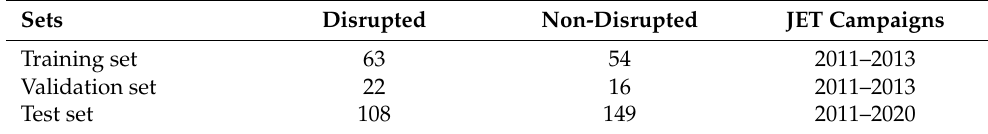
Table 2. Datasets for developing the models.